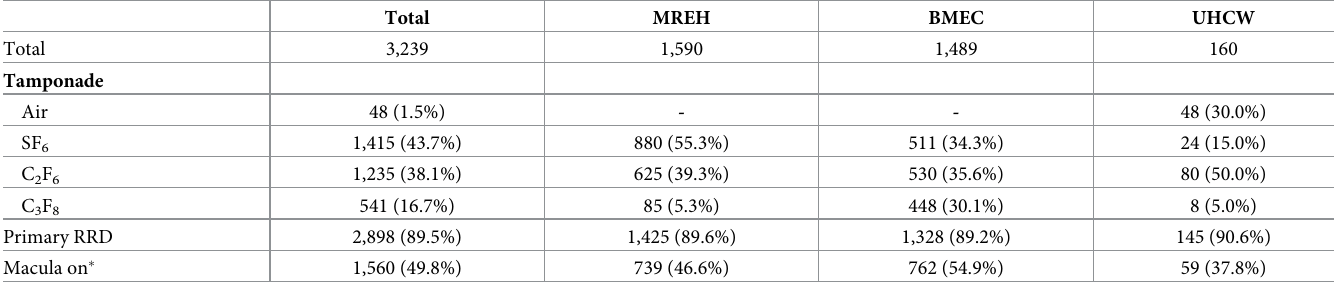
Table 2. Tamponade number by centre for rhegmatogenous retinal detachment